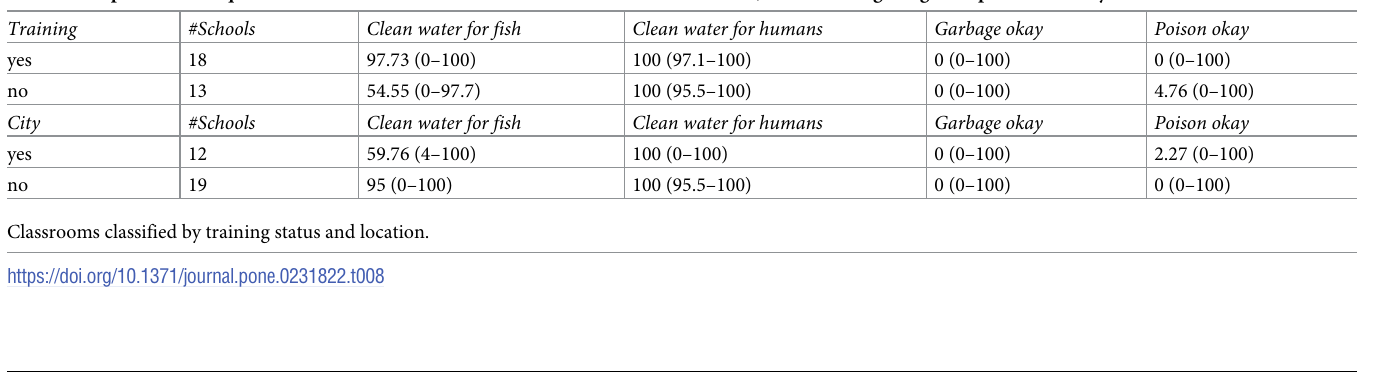
Table 8. Responses to the questions of whether human and fish need clean water to survive, and whether garbage and poison are okay. Training